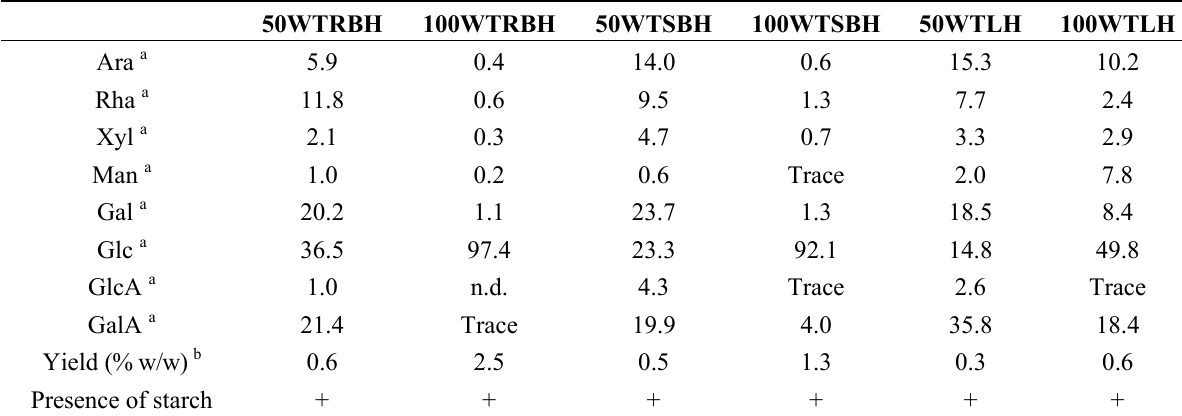
Table 1. Monosaccharide compositions of crude water extracts from root bark, stem bark and leaves of T. macroptera